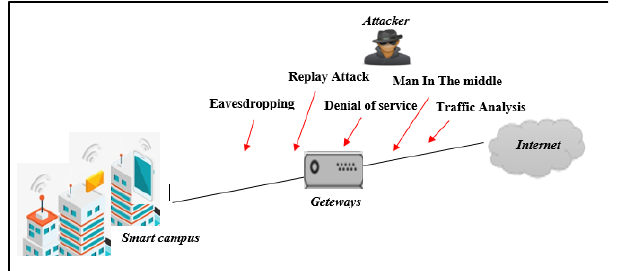
Figure 5. Network attacks in the smart